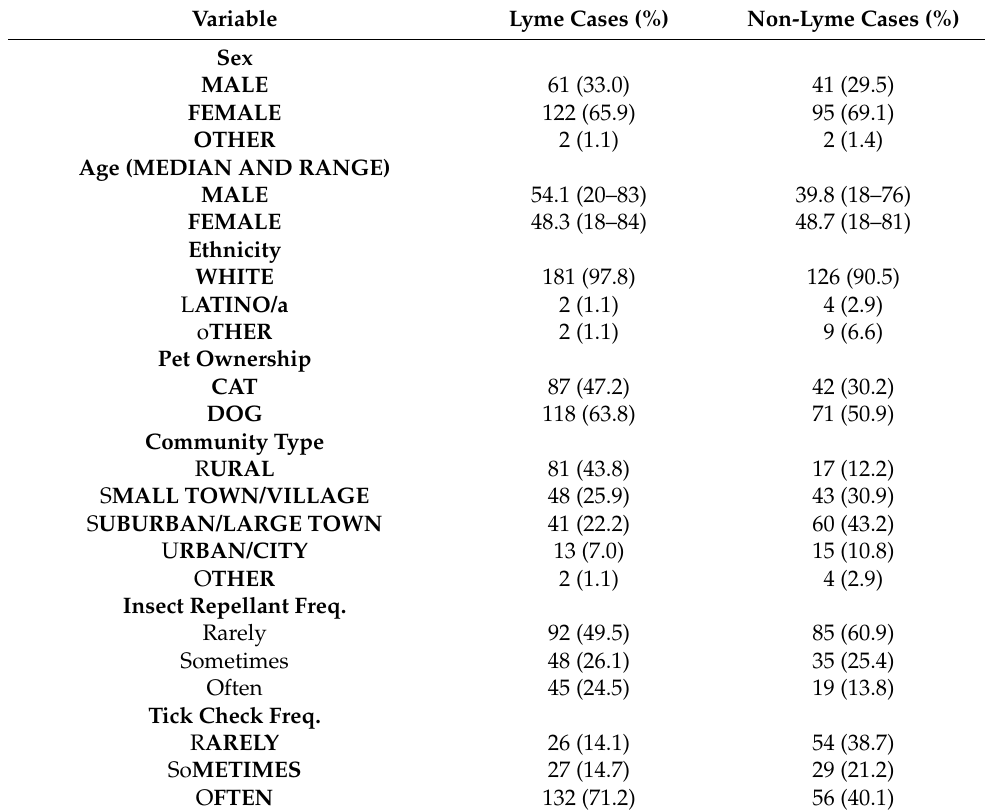
Table 1. Sample characteristics (N =